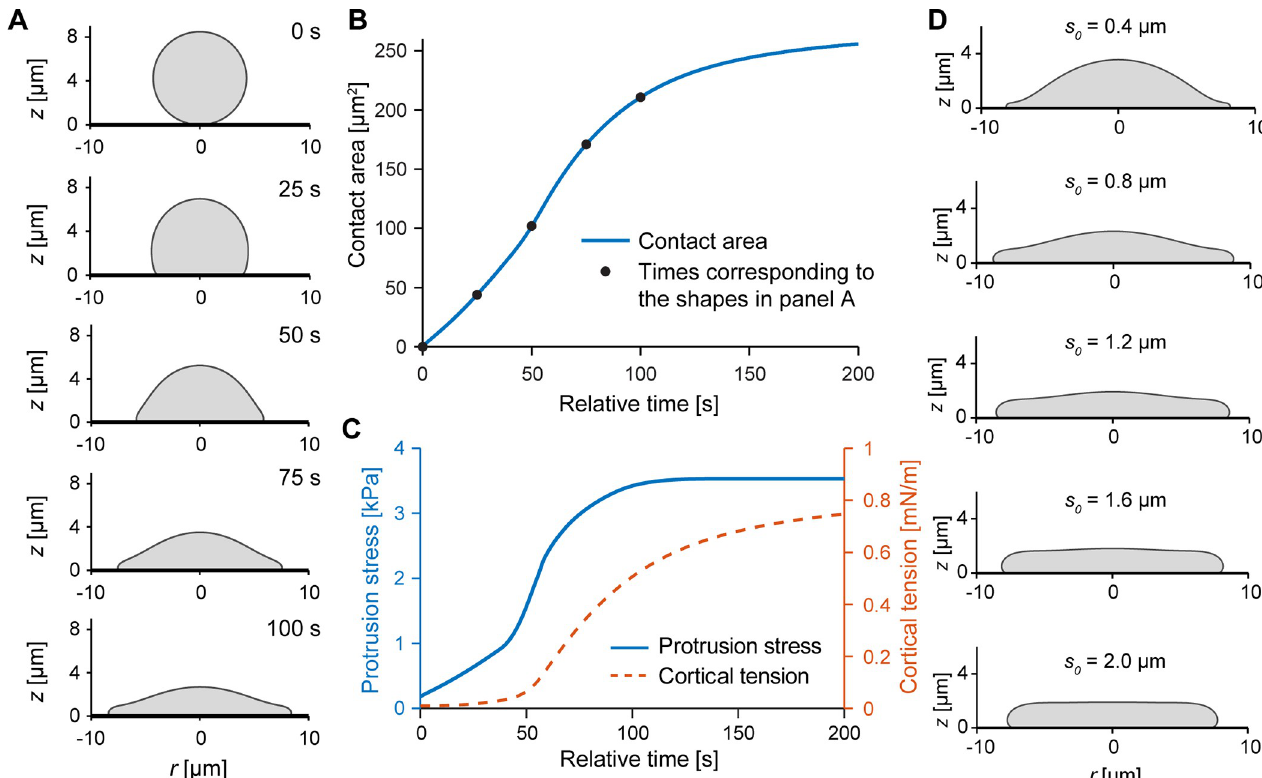
Fig 5. Predictions of the protrusive zipper model in the absence of adhesion stress. (A) For purely protrusion-driven spreading, lamellar pseudopods form as the protrusion stress increases over time. Time stamps of the the shown sample shapes are included. (B) Contact area increases sigmoidally over time for the protrusive zipper model, in good agreement with our measurements of the time course of the mean contact area on the highest density of IgG. Filled circles indicate where the shapes shown in panel A were computed. (C) Protrusion stress (governed by Eq (11)) and cortical tension (governed by Eq (1)) increase during cell spreading. (D) Varying the parameter s determines the thickness of the leading lamella, resulting in a thin pseudopod for s 0 coordinated global cell deformation for s 0 = 2.0 μ m (bottom). The sample shapes are shown at 120 s. All other protrusive zipper simulations in this paper were carried out using s = 0.8 μ 0